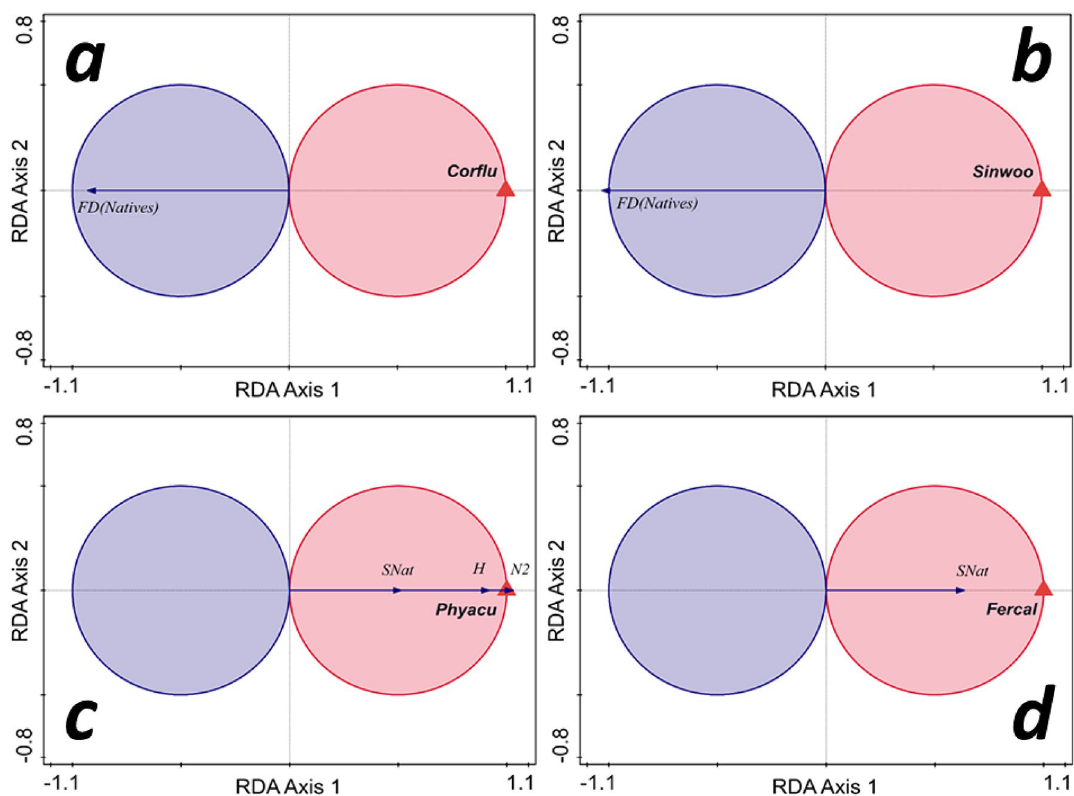
Figure 6. The t-value biplot (Van Dobben circles) for the response of Rao functional diversity of the native communities (FD(Natives)) to alien invasive species counts (AIS), with ( a ) significant negative effect of Corbicula fluminea (Corflu) and ( b ) marginally significant effect of Sinanodonta woodiana (Sinwoo), and for the response of taxonomic diversity measures (SNat—number of native species, H—Shannon index, N2—Hill’s measure) of native communities in relation to AIS counts; two species of gastropods, ( c ) Physa acuta (Phyacu) and ( d ) Ferrissia californica (Fercal) had a significant positive effect. All the other relations of response variables with AIS were not